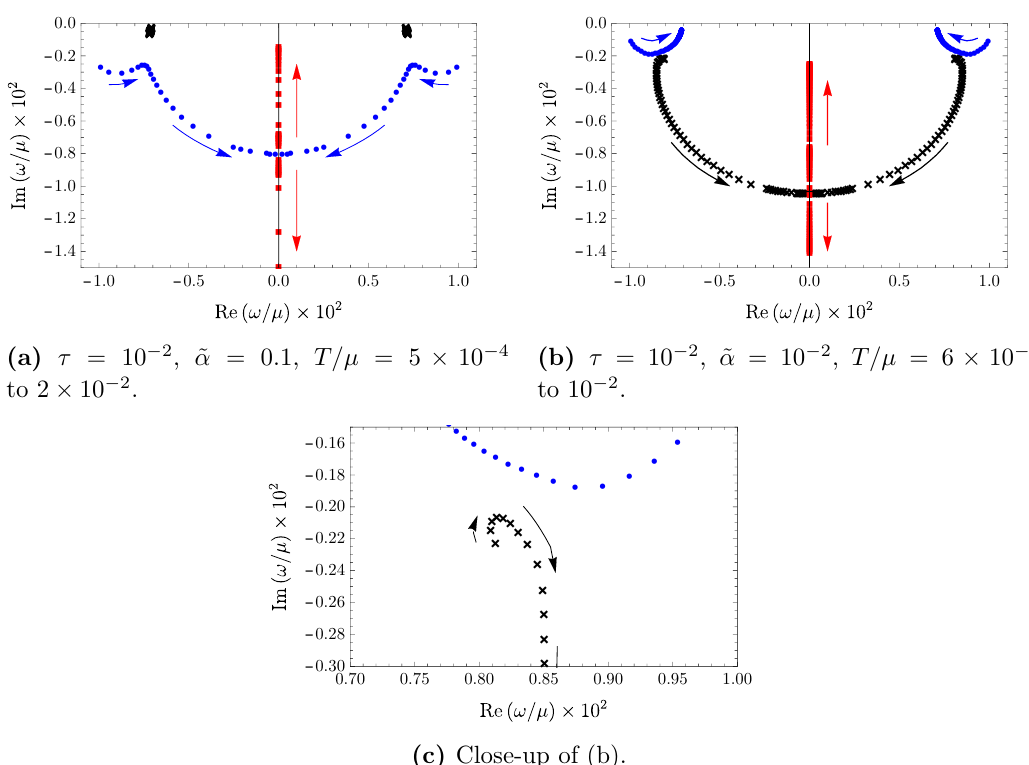
Figure 11. Positions of poles of G J and G tt in the complex !=(cid:22) plane with (cid:28) = 10 (cid:0) 2 for di(cid:11)erent ~ (cid:11) . We have enhanced Re ( !=(cid:22) ) and Im ( !=(cid:22) ) by 10 2 for clarity. The arrows indicate the movement of poles as T=(cid:22) increases. (a) and (b) ~ (cid:11) = 0 : 1 and 5 (cid:2) 10 (cid:0) 4 (cid:20) T=(cid:22) (cid:20) 2 (cid:2) 10 (cid:0) 2 . At T=(cid:22) = 5 (cid:2) 10 (cid:0) 4 we (cid:12)nd four poles, two HZS poles (black crosses) and two relativistic poles (blue dots). As T=(cid:22) increases the black crosses move very little but eventually become hydrodynamic sound poles, while the blue dots move down, then up, and then down and towards the imaginary axis, where they collide and split into two imaginary poles, one of which becomes the hydrodynamic charge di(cid:11)usion pole. (c) and (d) ~ (cid:11) = 10 (cid:0) 2 and 6 (cid:2) 10 (cid:0) 4 (cid:20) T=(cid:22) (cid:20) 10 (cid:0) 2 . At T=(cid:22) = 6 (cid:2) 10 (cid:0) 4 we again (cid:12)nd four poles, two HZS (black crosses) and two relativistic (blue dots). However now as T=(cid:22) increases the blue dots move down and then back up, becoming hydrodynamic sound, while the black crosses execute a loop-the-loop and then move down and towards the imaginary axis, where they collide and split into two imaginary poles, one of which becomes the hydrodynamic charge di(cid:11)usion pole.